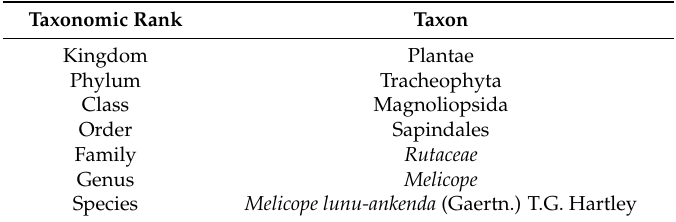
Table 2. The taxonomy of M. lunu-ankenda